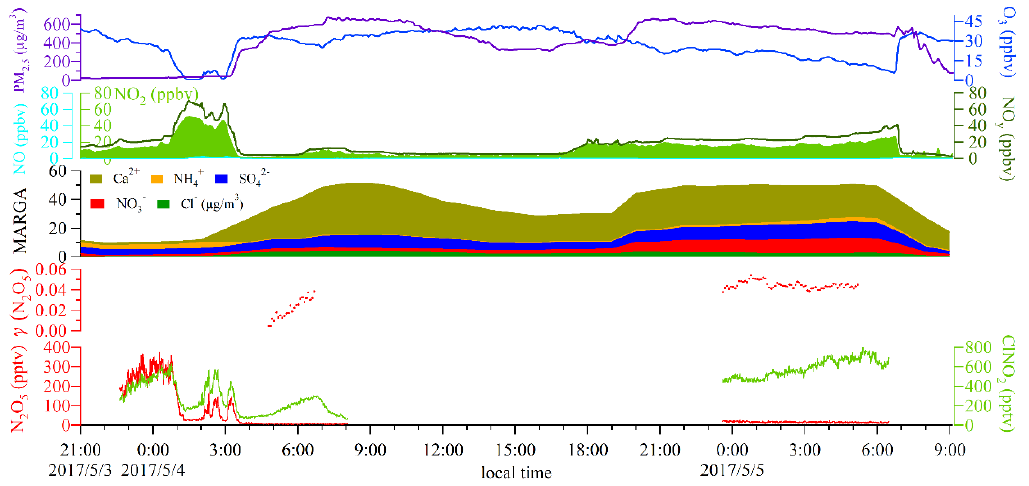
Figure 3. Time series of N 2 O 5 , ClNO 2 , and related species in a heavy sand storm event on the night of 3 rd and 4 th May. Also shown is the 5-min average γ(N 2 O 5 ) (see section 3.3).